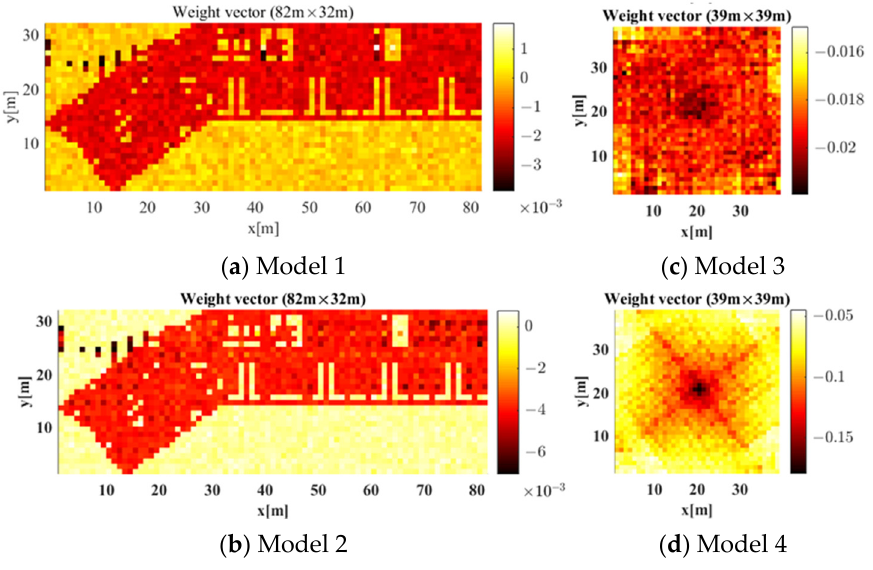
Figure 13. Weight Vectors of Model 1 to 4.